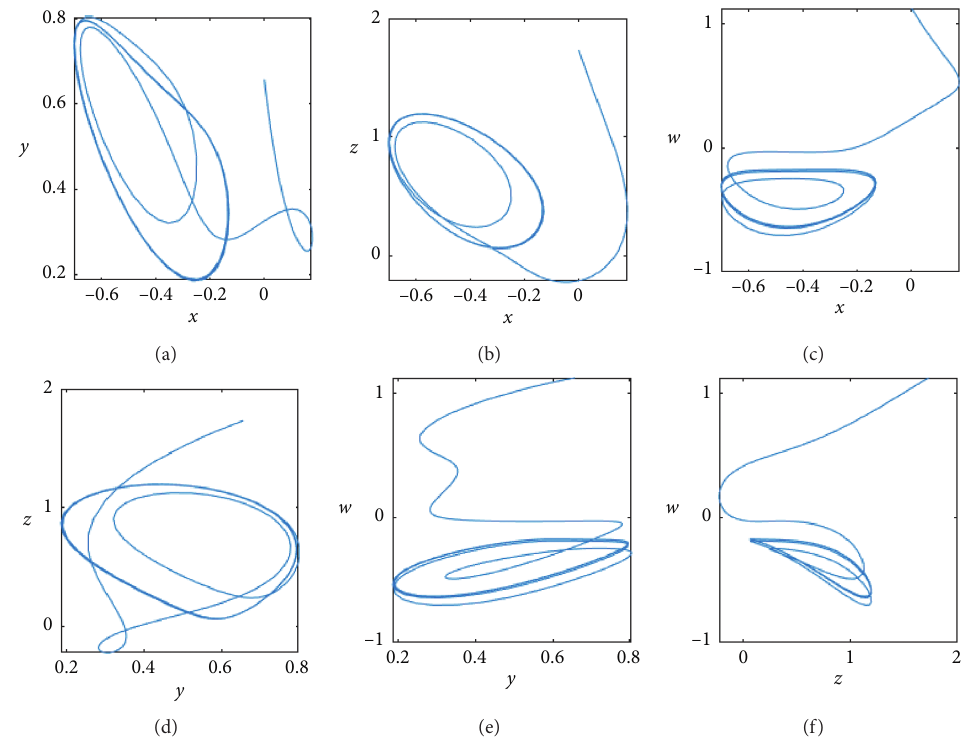
Figure 7: Two-dimensional plane phase diagram of system (1) with identified